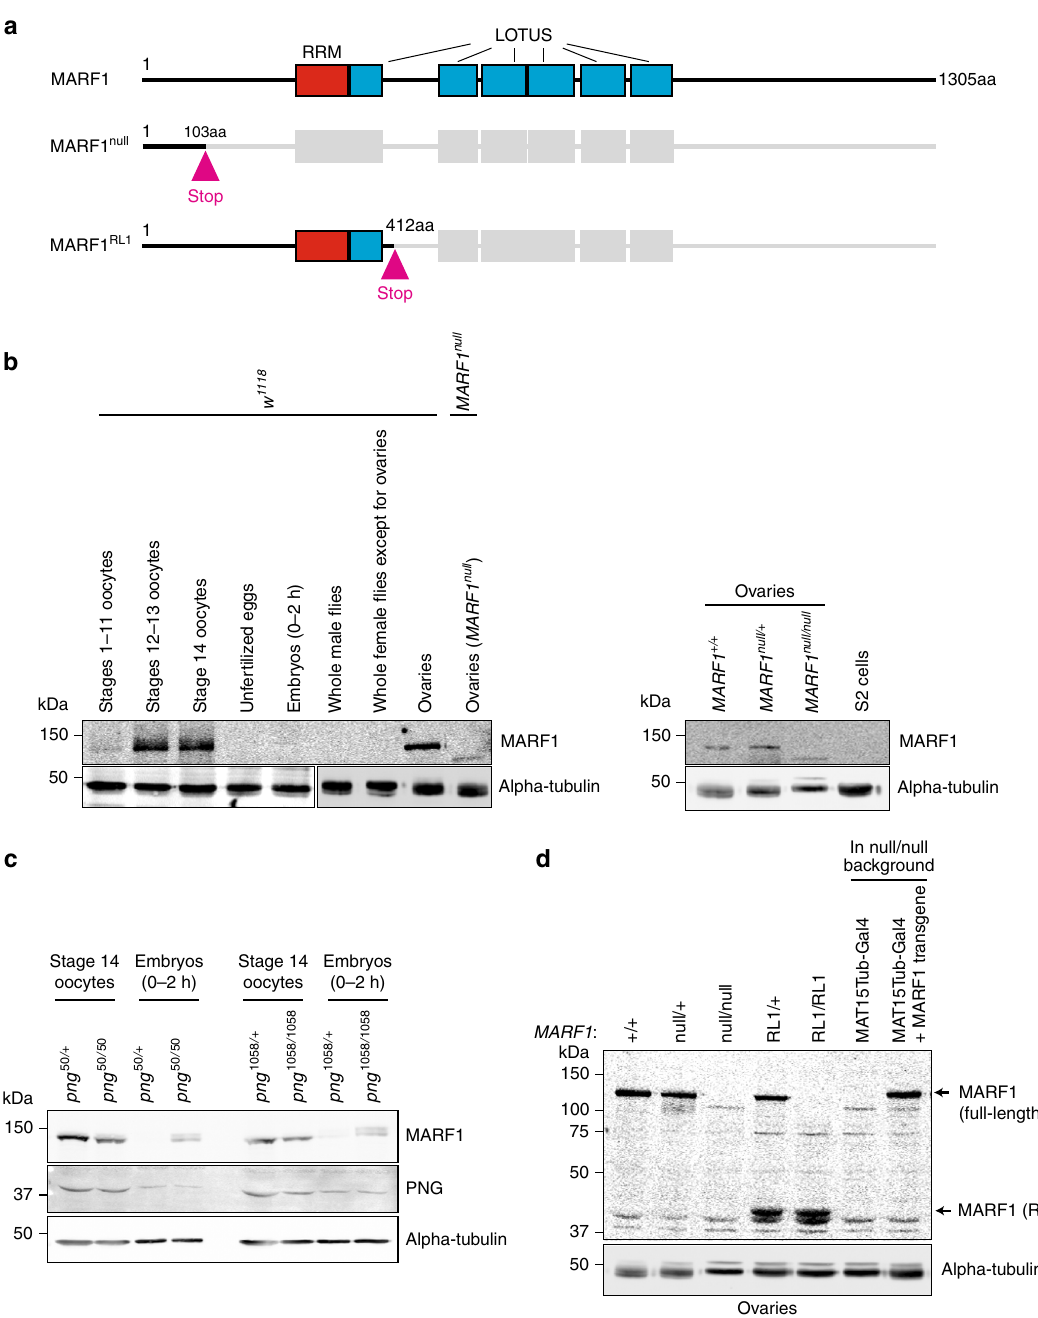
Fig. 1 MARF1 domain structure, mutant alleles, and protein expression pattern. a Domain structures of full-length Drosophila MARF1, MARF1 null , and MARF1 RL1 . b MARF1 Western blots of dissected oocytes/tissues from control w 1118 fl ies, ovaries from MARF1 null ( = MARF1 nlul/null ) and MARF1 null/ + , and S2 cells. c Western blots of dissected oocytes and embryos from png missense homozygous mutant fl ies ( png 50/50 and png 1058/1058 ) and their heterozygous control fl ies ( png 50/ + and png 1058/ + ). No difference in PNG protein level were observed between homozygous mutant and heterozygous control fl ies. d Western blots of ovary lysates. Transgenic MARF1 protein, which was expressed from the transgene UASP-3xHA- MARF1 driven by the germline-speci fi